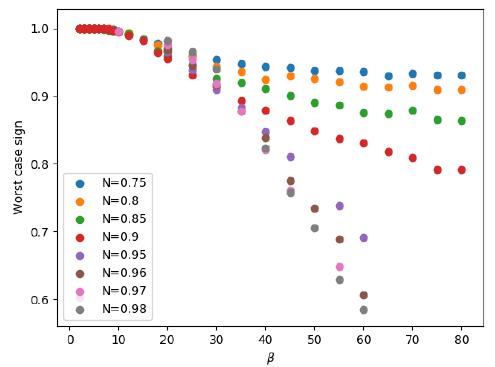
Figure A1. Average sign as a function of inverse temperature, β = 1/ T , for different fillings. We set α = 0.51 for all the simulations